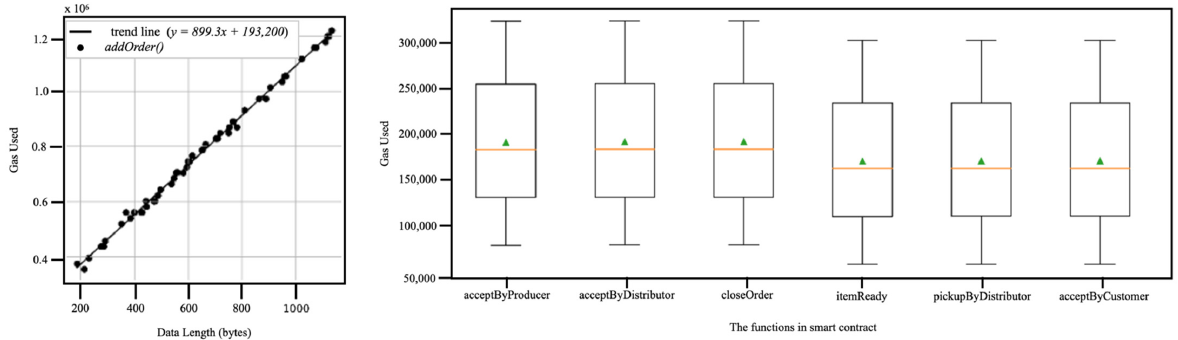
Figure 4. The gas used of addOrder() increases as a linear function ( y = 899.3x + 193,200, R 2 = 0.9940). The gas used by other functions is not significantly different (F-score = 34.47, F-critical = 2.24, p -value = 0.00).